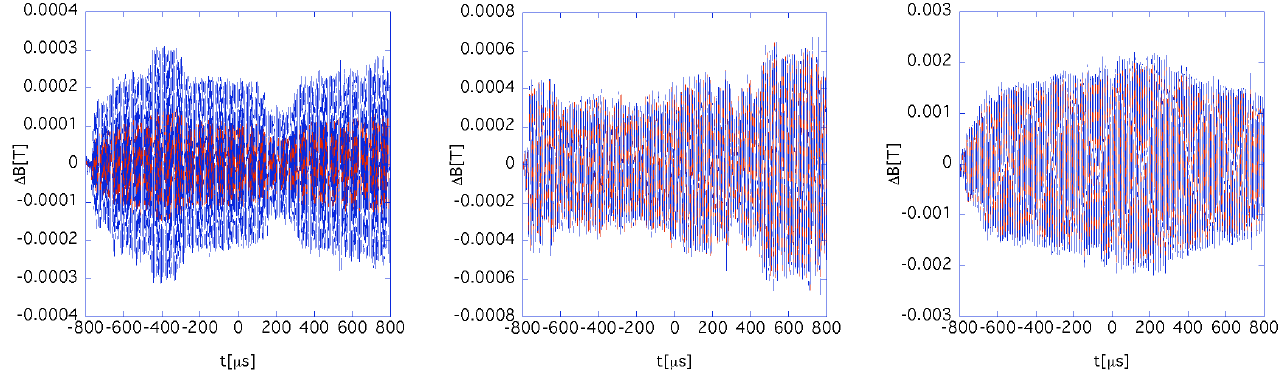
FIG. 30. (Color) The comparison of the field modulation (theoretical results) obtained by Eq. (25) with that done by Eq. (26) (when the original magnetic field is assumed to be excited, following the measured data that is given by the left of Fig. 16). The blue points represent the results calculated by Eq. (25) and red points do those done by Eq. (26). The left, middle, and right figures show the cases that the number of working capacitors k is equal to 20, 60, and 100, respectively. As the number of working capacitors is larger, the approximation that the magnetic field on x ¼ 0 plane is constant becomes appropriate.